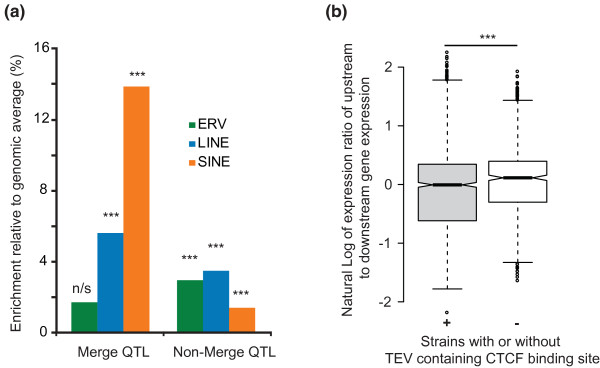
Enrichment of TEVs within merge QTL regions and functional impact of CTCF-binding TEVs. (a) The density of TEVs within genomic intervals associated with refined ('Merge') QTLs or adjacent sequence lying within nonrefined QTLs relative to all genomic regions was tested using a genome-wide association test. SINE TEVs show a 13.9% enrichment in regions associated with refined merge QTLs over the level expected given interval size and GC composition. Both LINE and SINE TEVs show greater densities within merge QTL regions compared to surrounding non-merge QTL sequence. With the exception of ERV TEVs in merge QTL regions, all associations were statistically significant (***P < 10-3). (b) Variation in expression between genes associated with a CTCF-binding TEV. The natural log of the ratio of expression between the upstream and downstream genes (whose order was randomly assigned) was taken as a measure of the variance in expression. The presence of the CTCF binding TEV was associated with a greater degree of expression variation between flanking genes (ANOVA P < 0.001). N/s, not significant.